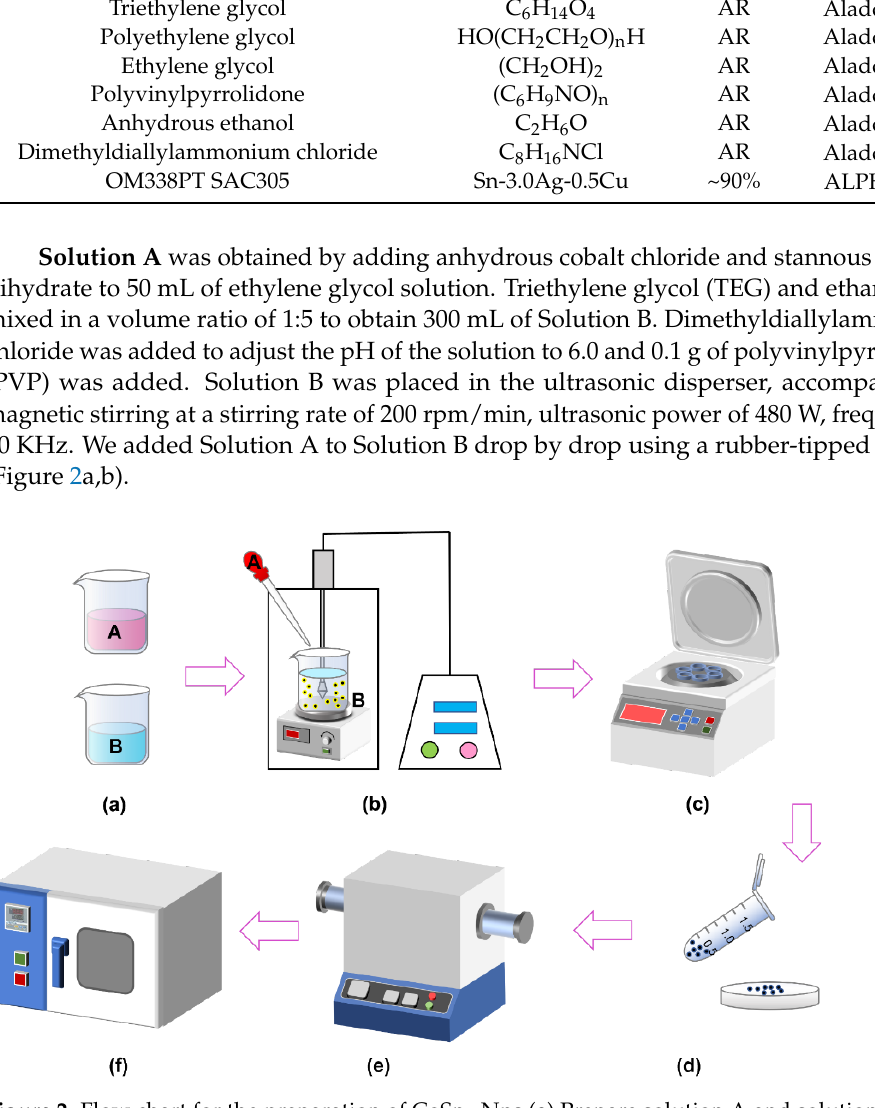
Figure 2. Flow chart for the preparation of CoSn 3 Nps.( a ) Prepare solution A and solution B ( b ) Reduction in ultrasonic environment ( c ) The product of reduction reaction is obtained by centrifugation after deionized water cleaning ( d ) The product is transferred to the crucible and ethylene glycol is added.( e ) Tube furnace heating ( f ) After acid pickling with 15% dilute salt, the products are washed with deionized water and ethanol respectively, and then dried.